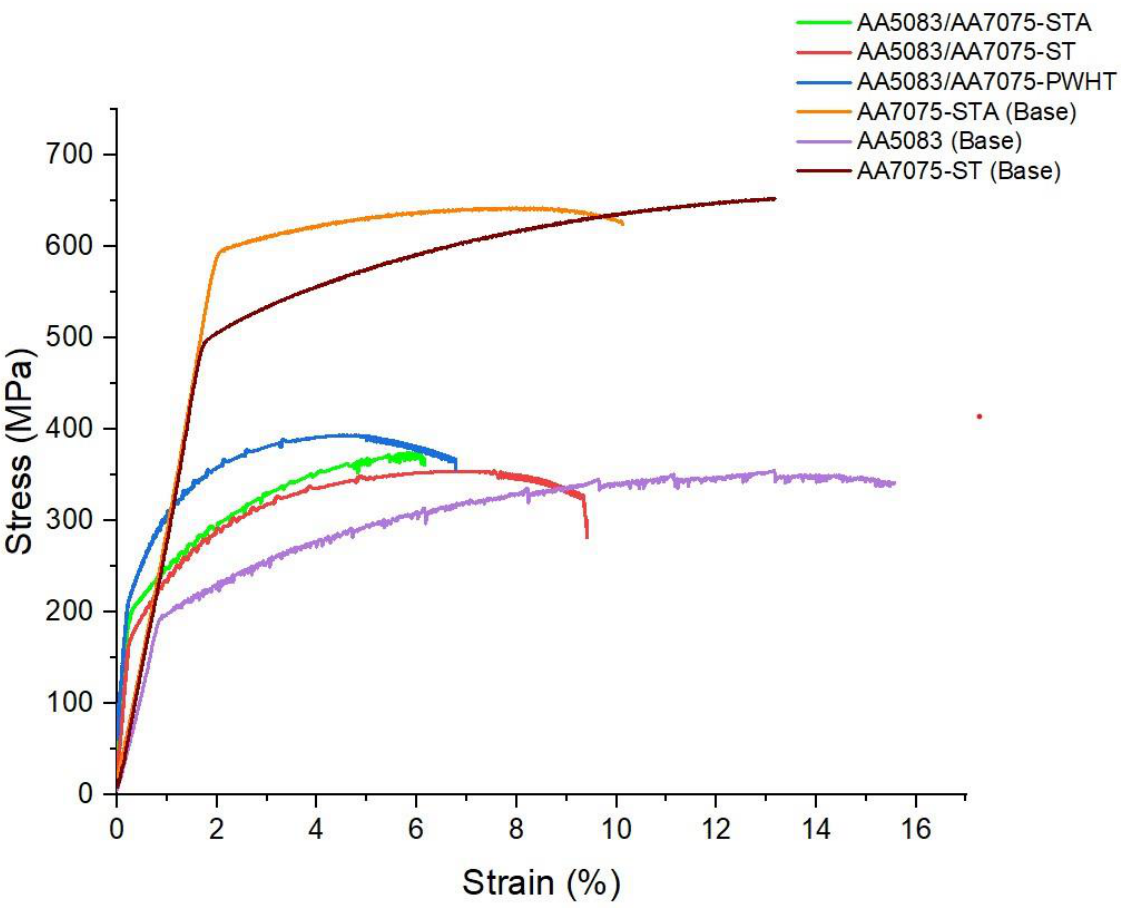
Figure 14. Tensile curves of welded samples and base